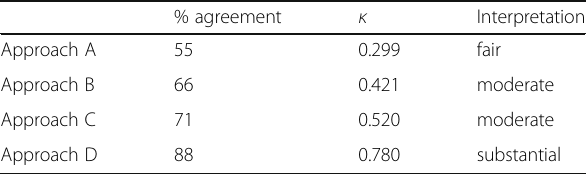
Table 4 Interobserver agreement for the diagnosis of partial ACL tear % agreement